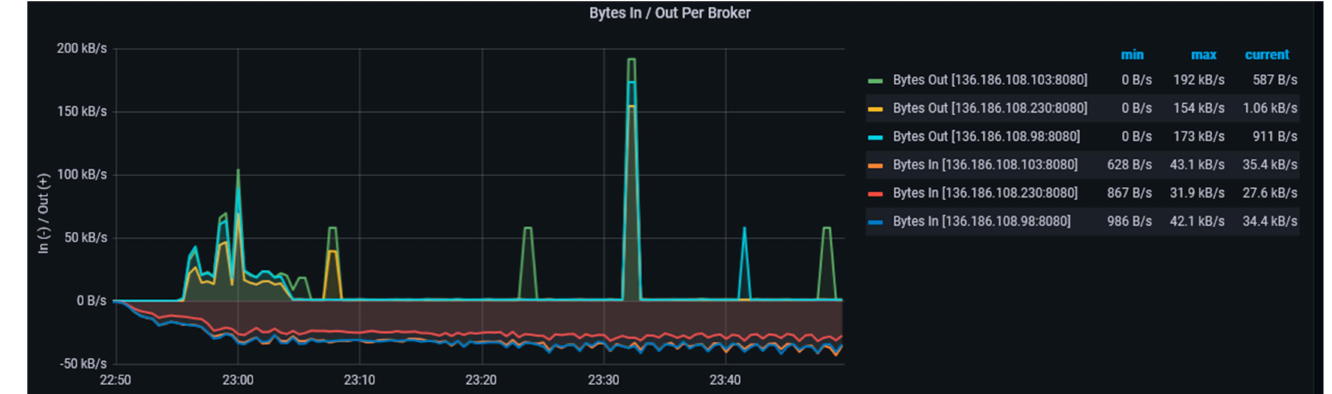
Figure 9. Bytes In/Out from broker indicating the overall throughput.